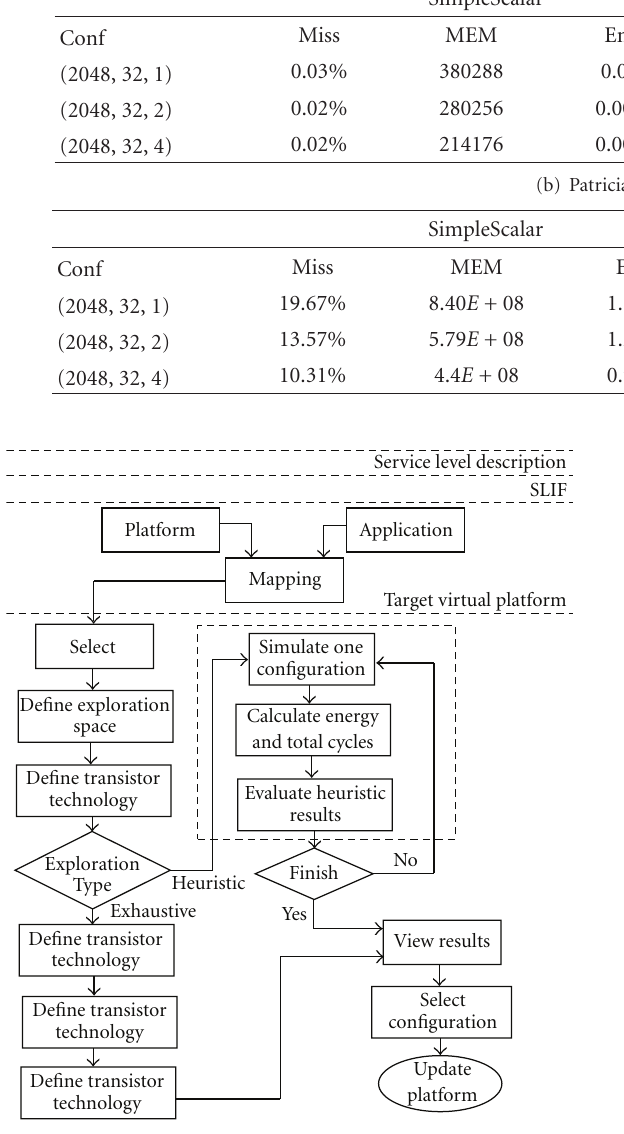
Figure 5: Energy consumption analysis flow.